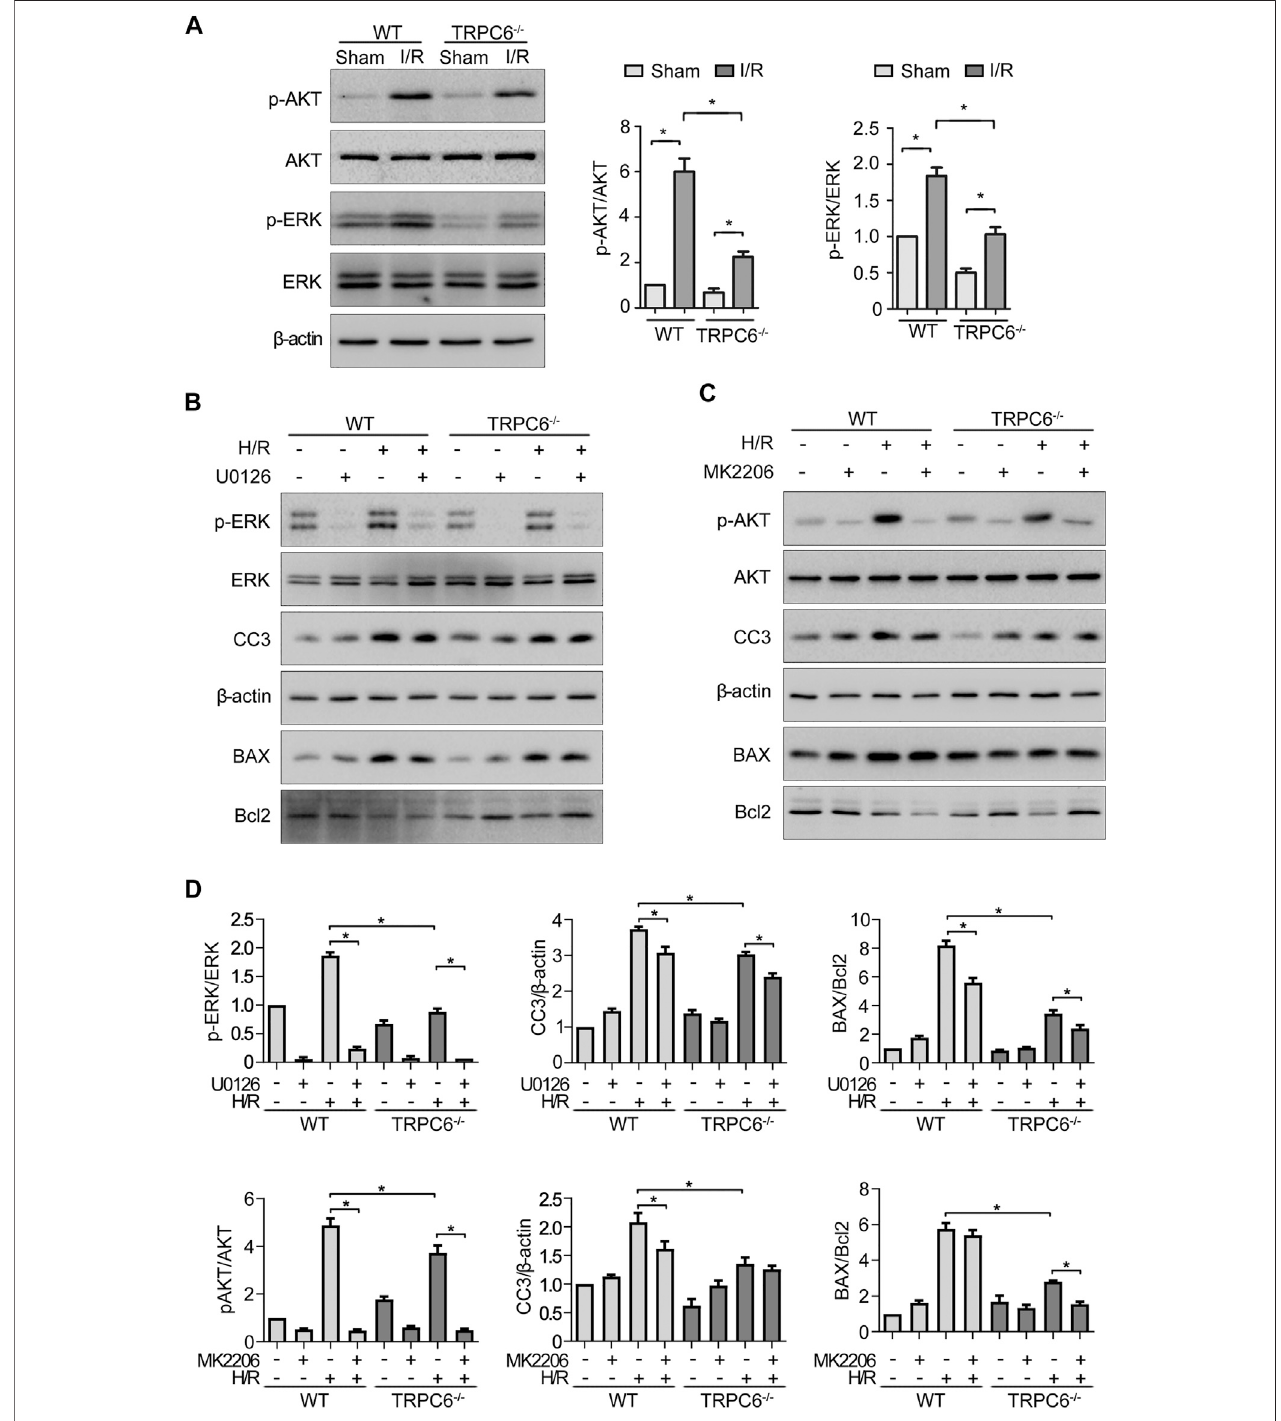
FIGURE6| TRPC6 knockoutreducesTEC apoptosisbydown-regulating PI3K/AKT/mTORandERK1/2 pathways. (A) Representativewesternblotimagesshow the level of phosphorylated and total AKT and ERK1/2 expressions of tissue lysates extracted from WT and TRPC6 − / − mice. Bars represent mean ± SEM, n (cid:2) 3, * p < 0.05. (B, C) Representative western blot images show the level of phosphorylated and total AKT and ERK1/2, BAX, Bcl-2, and CC3 expressions after primary TECs subjected to H/R treatment and addition with inhibitors of AKT (MK2206) and ERK (U0126). (D) Bar graphs show the relativequanti fi cation of p-AKT/AKT, p-ERK/ ERK, CC3/ β -actin, and BAX/Bcl-2. Data are expressed as mean ± SEM, n (cid:2) 3, * p < 0.05.